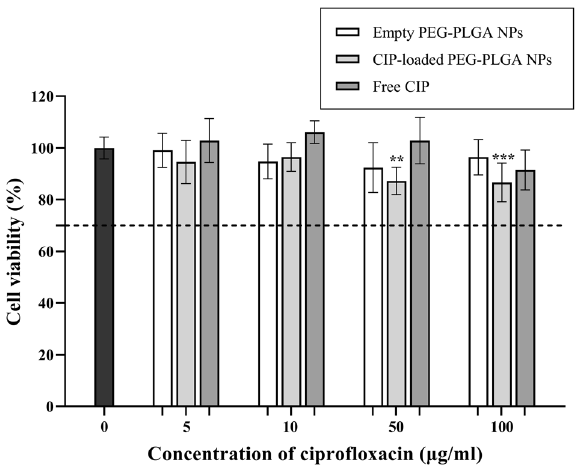
Figure 4. SCAP viability after being treated with empty PEG–PLGA NPs, CIP-loaded PEG–PLGA NPs, and free CIP for 24 h, the error bars represent the standard deviation from three independent